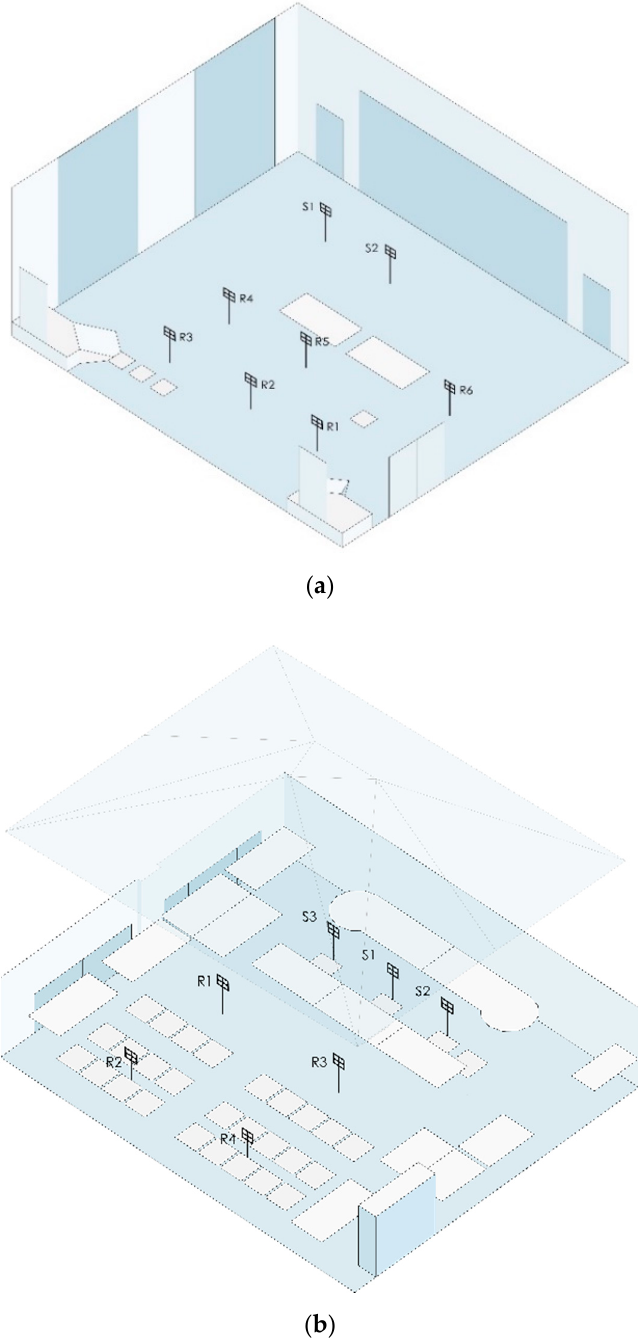
Figure 2. Layout of the measurement set-up in the two meeting rooms. S points represent the source position, while R points are the microphone positions in Mr1 ( a ) and Mr2 ( b ).